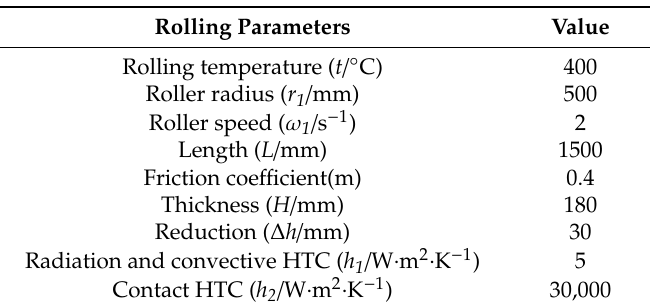
Table 1. The Main rolling Parameters.